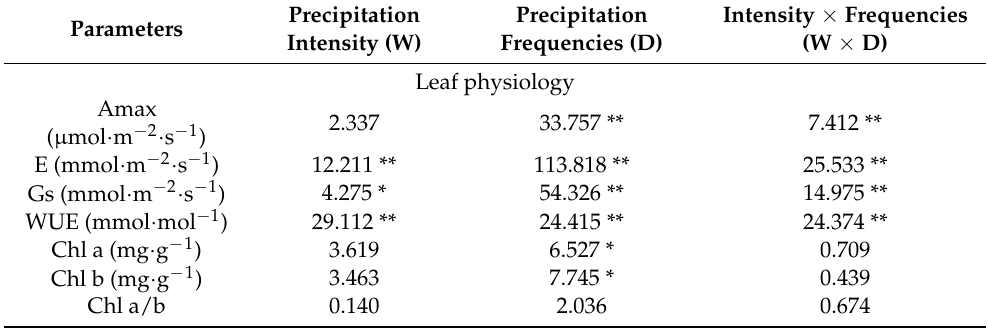
Table 1. F values of two-way ANOVA of different treatments on the parameters of R. pseudoacacia .